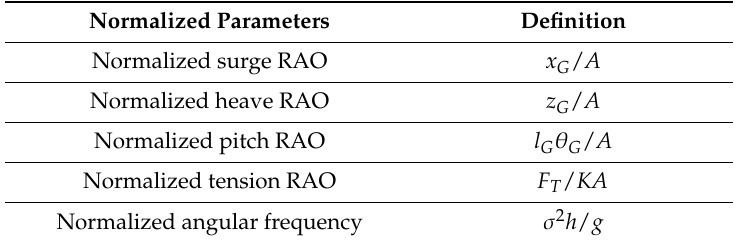
Table 3. Definition of the response amplitude operators (RAOs) and frequency.